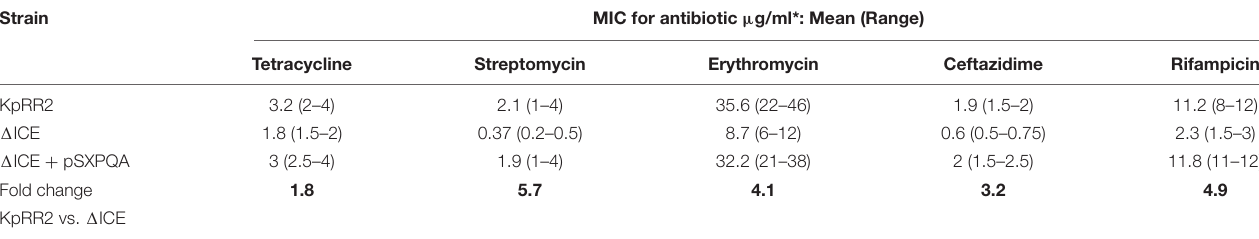
TABLE 1 | Minimum inhibitory concentrations (MIC) for K. pneumoniae KpRR2, the mutant (cid:49) ICE and complemented strain (cid:49) ICE + pSXPQA for five antimicrobials. Strain MIC for antibiotic µ g/ml*: Mean (Range)